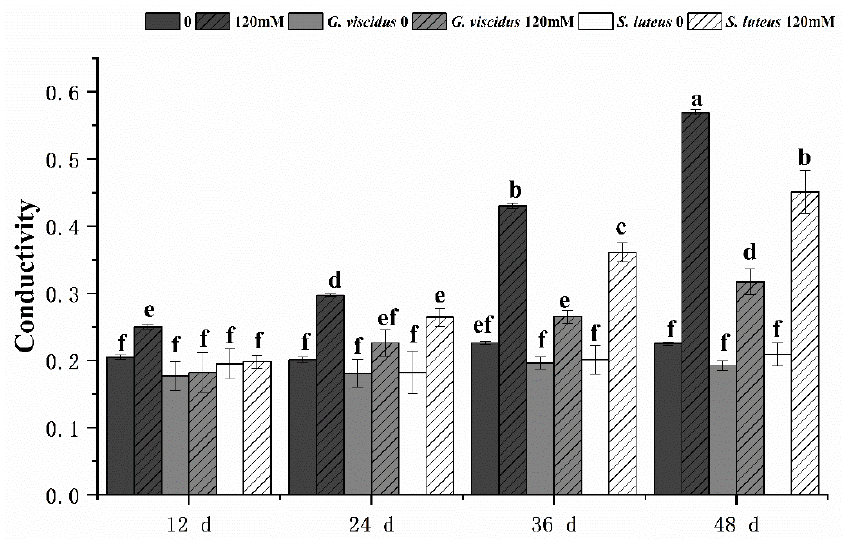
Figure 8. Changes in the relative conductivity in ectomycorrhizal seedlings of Q. mongolica under NaCl stress. Bars represent means of five replicates ( ± SD). For each parameter, bars with different letters indicate significant differences among treatments, p ≤ 0.05, following one-way